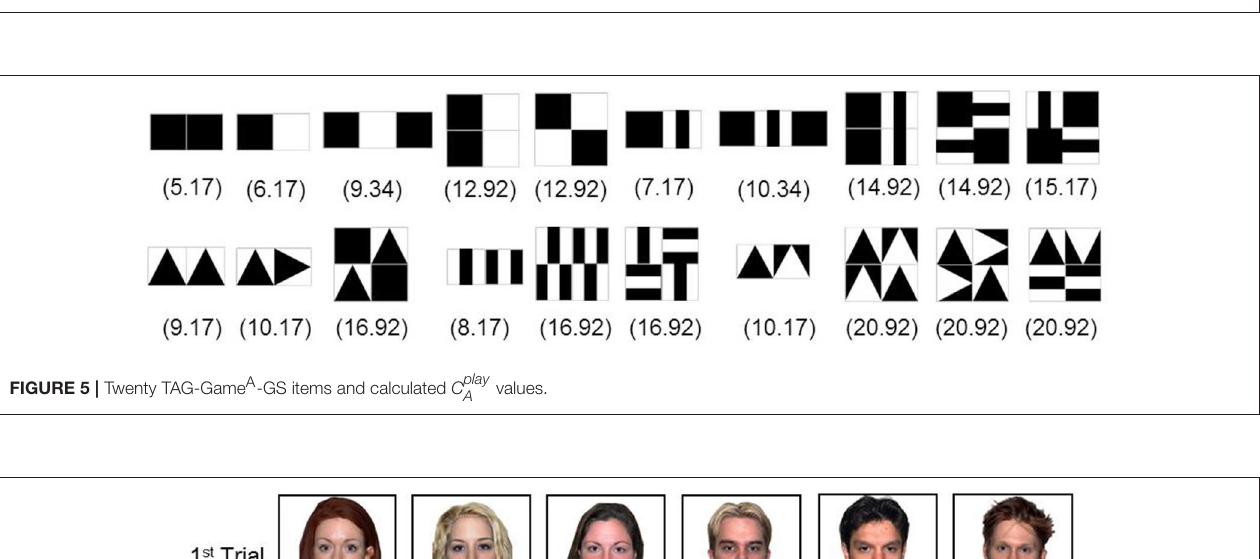
FIGURE 4 | Five types of SIG-Blocks used in the study: geometric shape (GS), color (CL), emoticon (EM), segmented animal face (AF), and segmented human face (HF).